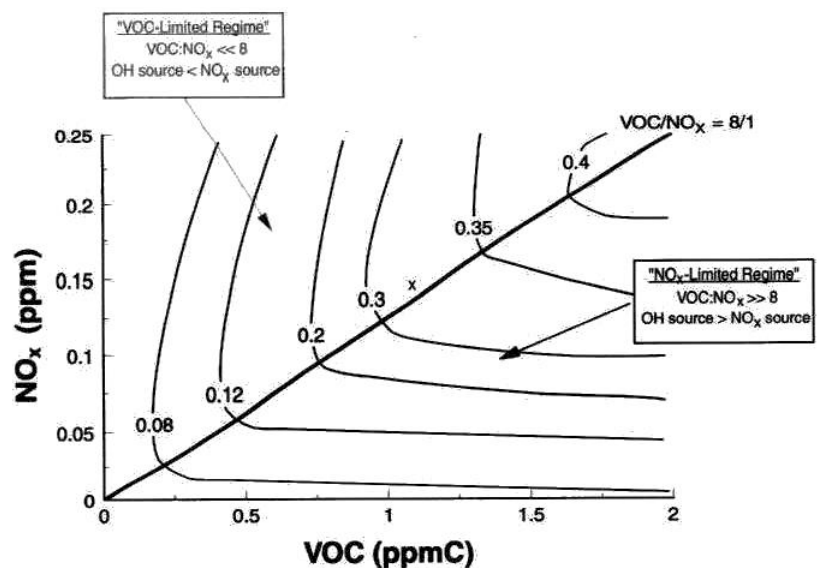
Figure 3. Textbook-handbook O 3 Isopleth Diagram showing the non-linear relationship between O 3 precursors and O 3 concentrations as curved iso-lines calculated from the EKMA mechanism) [168].